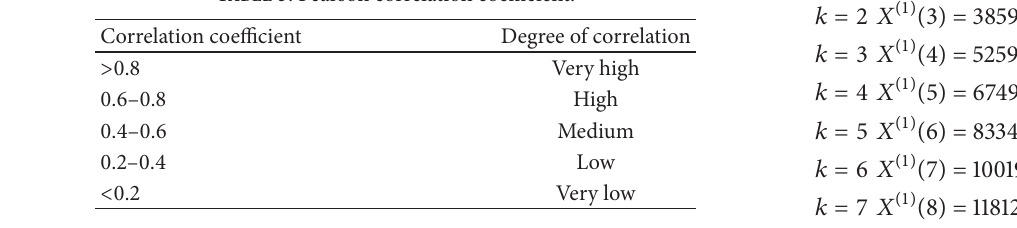
Table 5: Pearson correlation